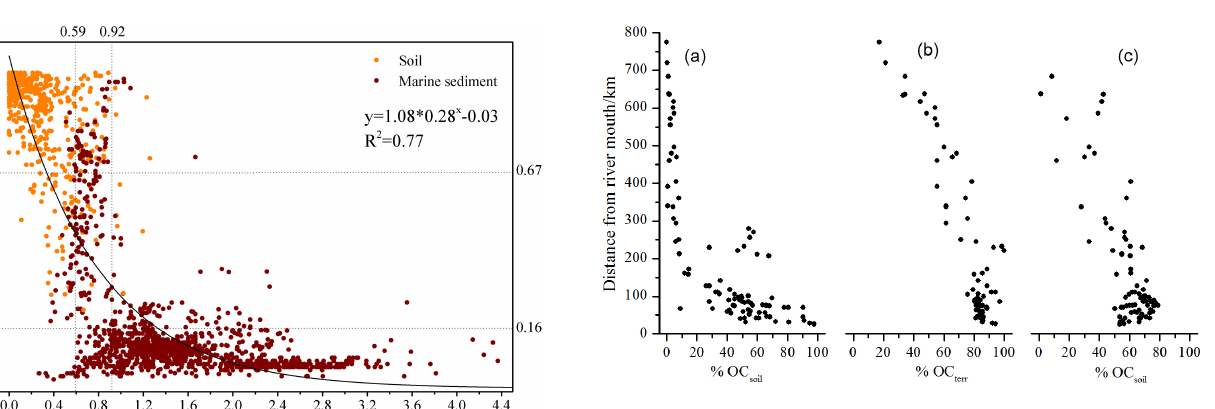
Figure 8. Percentage of soil organic carbon (%OC soil ) or terres- trial organic carbon (%OC terr ) based on a binary mixing model of BIT (a) , δ 13 C org (b) and IIIa / IIa (c) for the East Siberian Arctic Shelf (Sparkes et al.,